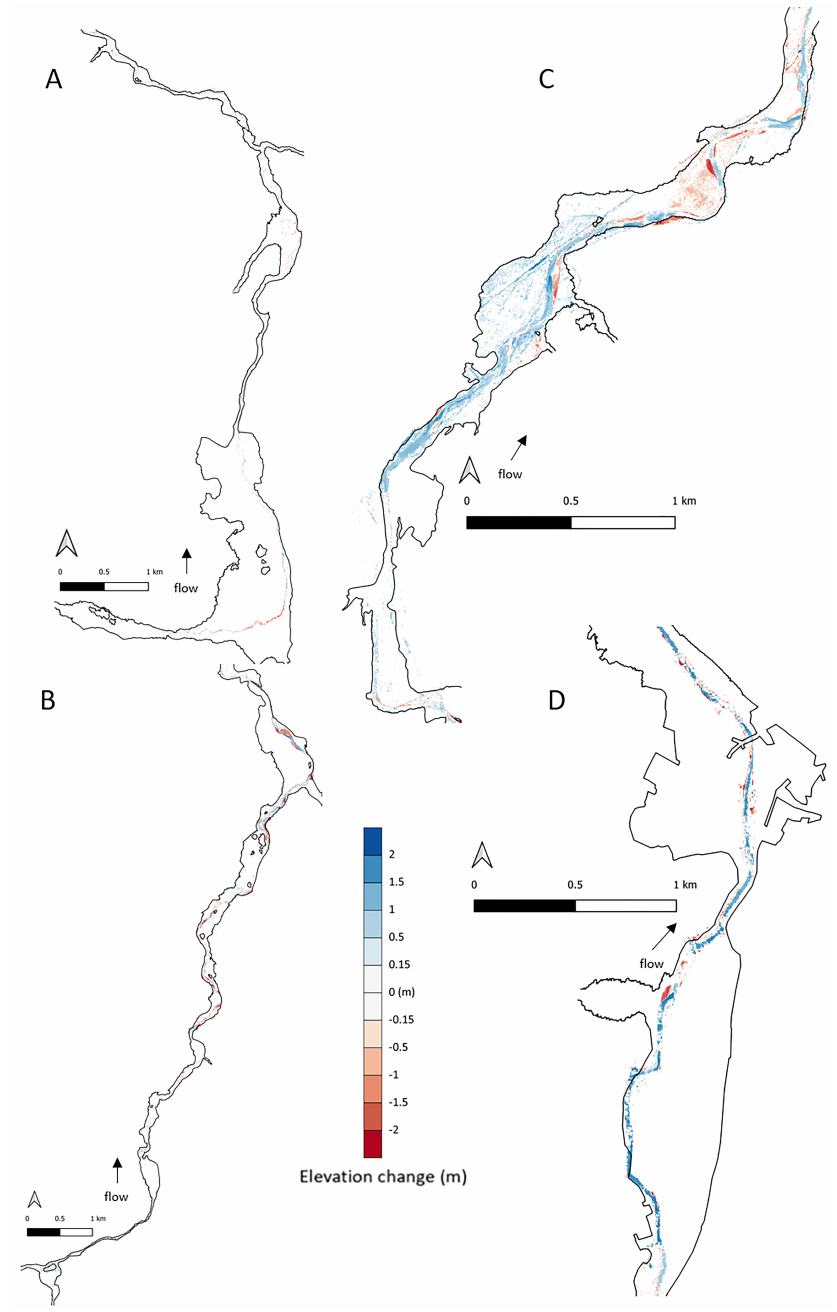
Figure 4. Overall erosion and deposition pattern along the four reaches of the River Caldew study area measured between 2005 and 2016. The black boundary is Environment Agency flood zone 3 representing the 1:100 year return period flow on the annual maximum series. The overall pattern of erosion and deposition for the period 2005 to 2016 shows that the channelised Reach A upstream of Hesketh Bridge is remarkably stable with almost no evidence of any activity outside of the active channel ( A ). Reach B is more active; erosion and deposition are more confined to the river edge with localised erosion and associated deposition increasing channel sinuosity ( B ). The incipient wandering Reach C below Buckabank exhibits general bed raising linked to the development of major bar complexes and overbank splay deposits can be seen extending onto the floodplain. This reach displays the strongest floodplain activity ( C ). Reach D is heavily engineered entering Carlisle and change is restricted to the active channel where deposition dominates ( D